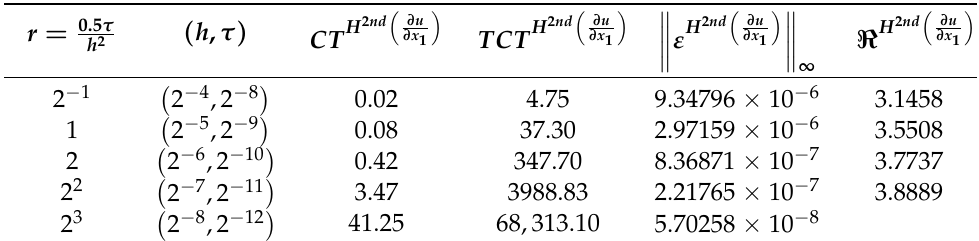
> 3 when r = 0.5 τ . 7 ∂ x 1 h 2